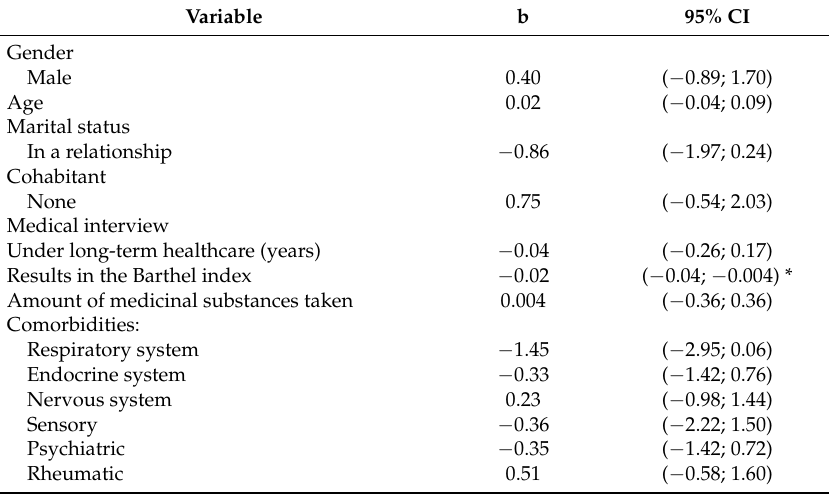
Table 2. Analysis of the linear regression of the depression risk (GDS-SF) determinant in the examined